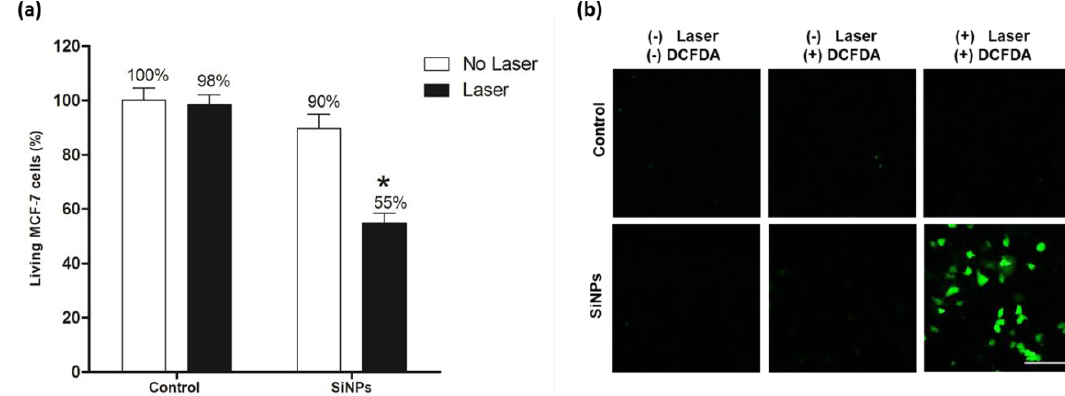
Figure 3. ( a ) TPE-PDT effect of SiNPs incubated 24 h with MCF-7 at 50 µg mL −1 . Cells were irradiated with pulsed laser at 900 nm (3 scans × 1.57 s). Data are presented as (mean ± SEM) of two independent experiments realized in triplicate. * Statistical significance ( p < 0.05) for silicon nanoparticles laser versus control no laser (student’s t -test); ( b ) Detection of intracellular reactive oxygen production by DCFDA in MCF-7 cells treated with 50 µg mL −1 of SiNPs and irradiated at 900 nm (3 scans × 1.57 s). Green fluorescence indicates ROS production as a consequence of PDT effect. Scale bar 30 µm.